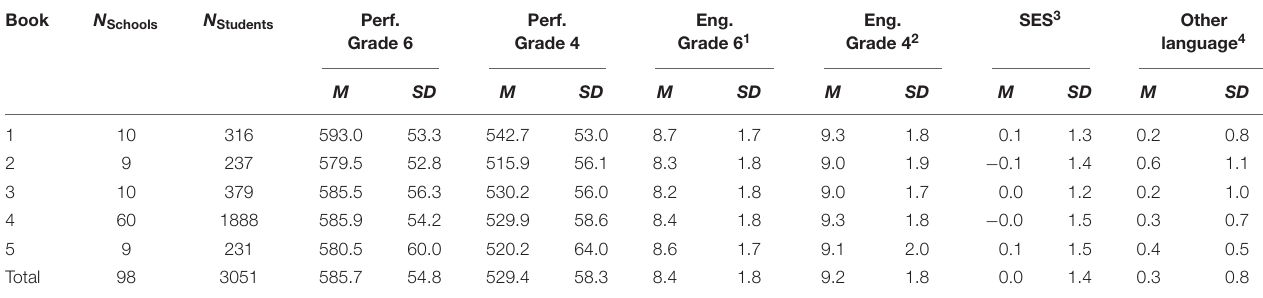
TABLE 2 | Descriptive statistics across textbooks.